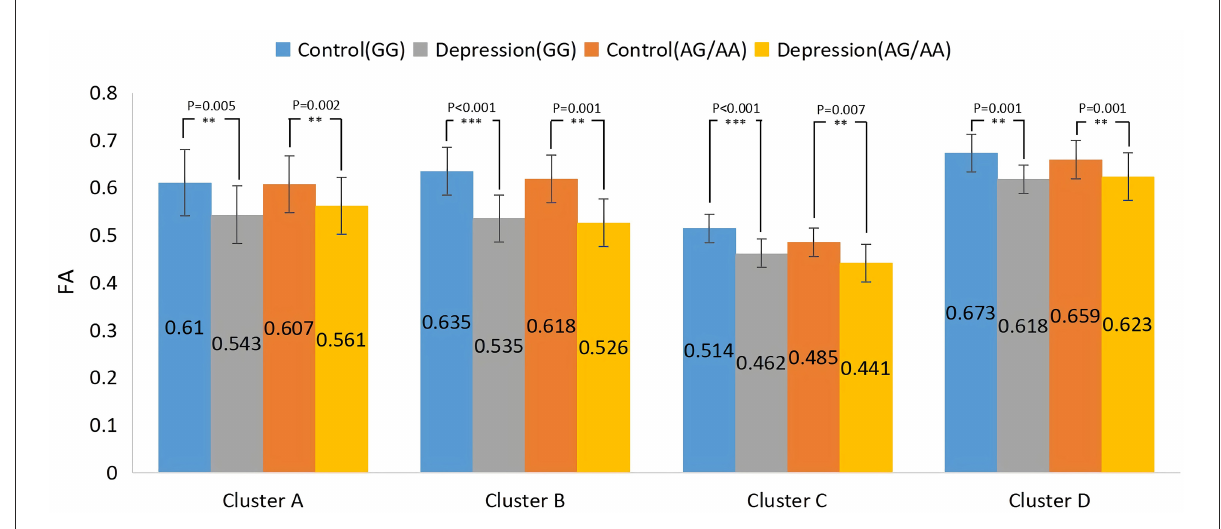
FIGURE6 Post-hoc analysis of the main effect of diagnosis on FA among the four groups. ** P < 0.01, *** P < 0.001.